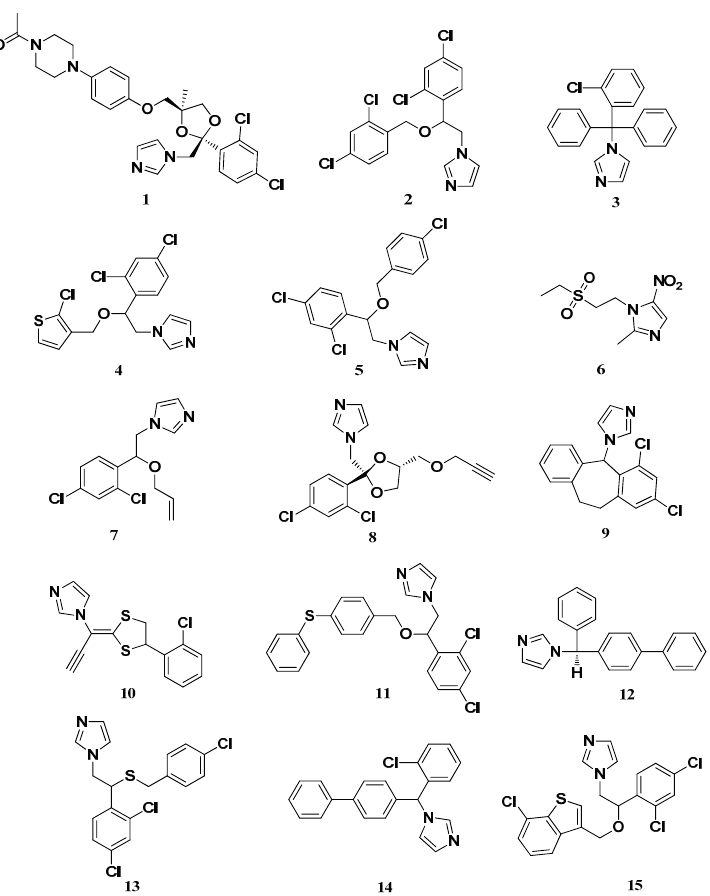
Figure 1. Marketed imidazole drugs.